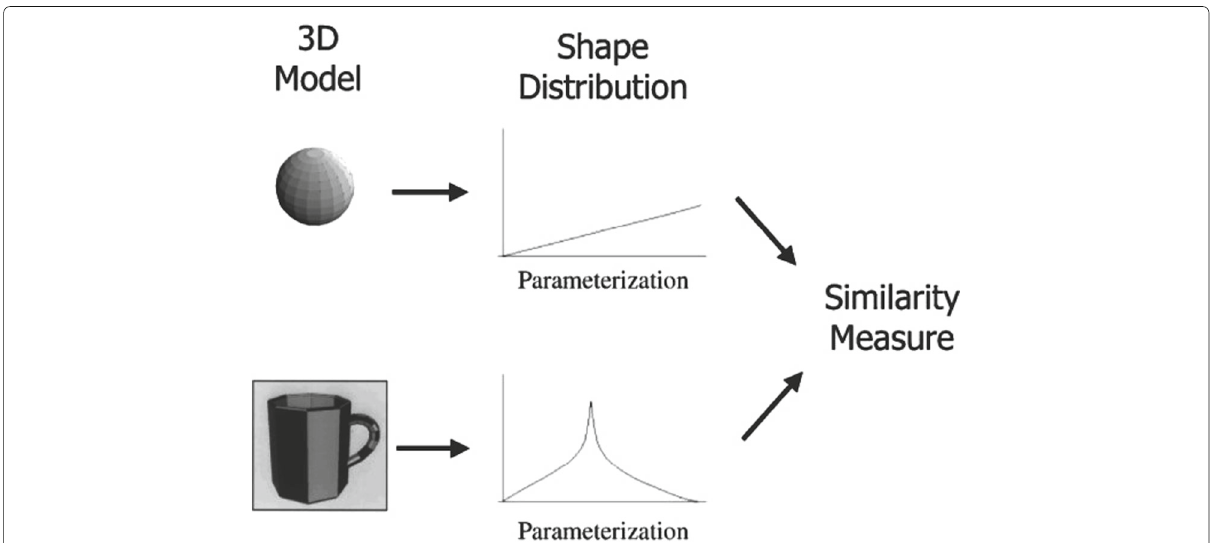
Fig. 2 Shape distribution-based similarity measurement [21]. The 3D models are represented as distribution of Euclidean shape functions and similarity is measured using histogram-based fidelity scores